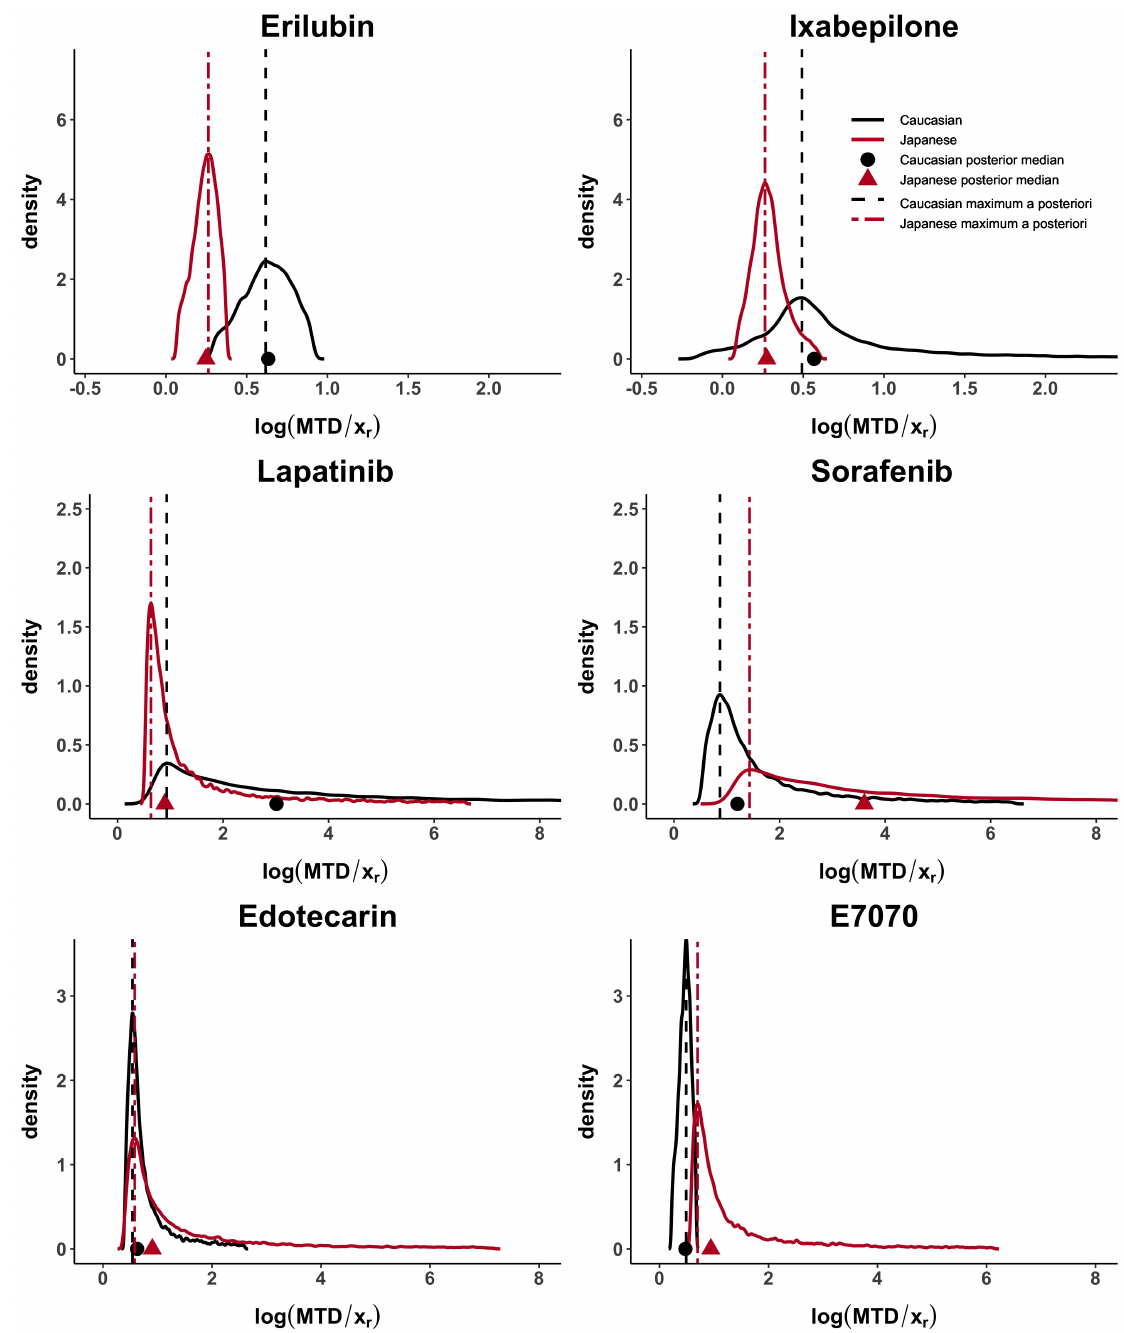
Figure 1. MTD posterior distributions for Erilubin, Ixabepilone, Lapatinib, Sorafenib, Edotecarin and E7070 case studies. Posterior medians are represented by a circle for Caucasian and a triangle for Japanese, while maximum a posteriori is represented by a dashed line for Caucasian and a two-dash line for